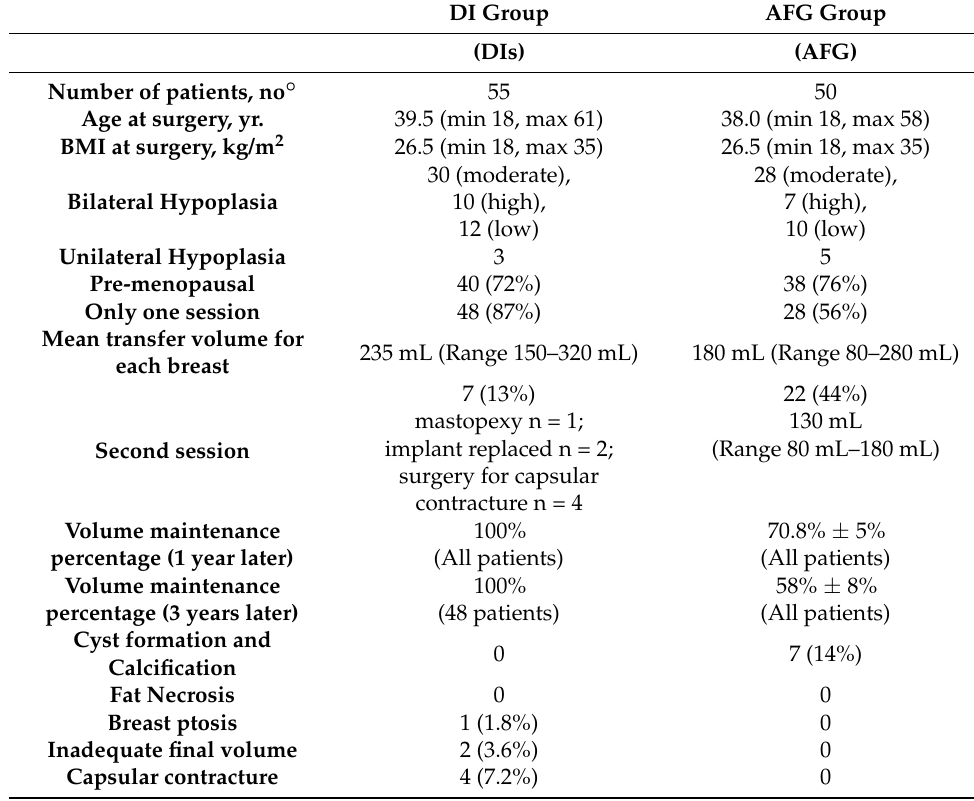
Table 1. Patients’ data and clinical